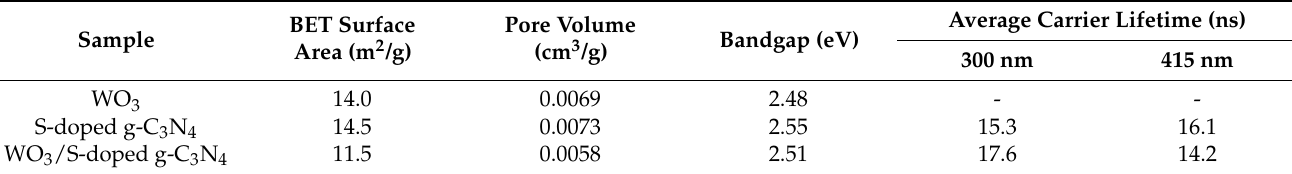
Table 1. Morphological and optical properties of obtained